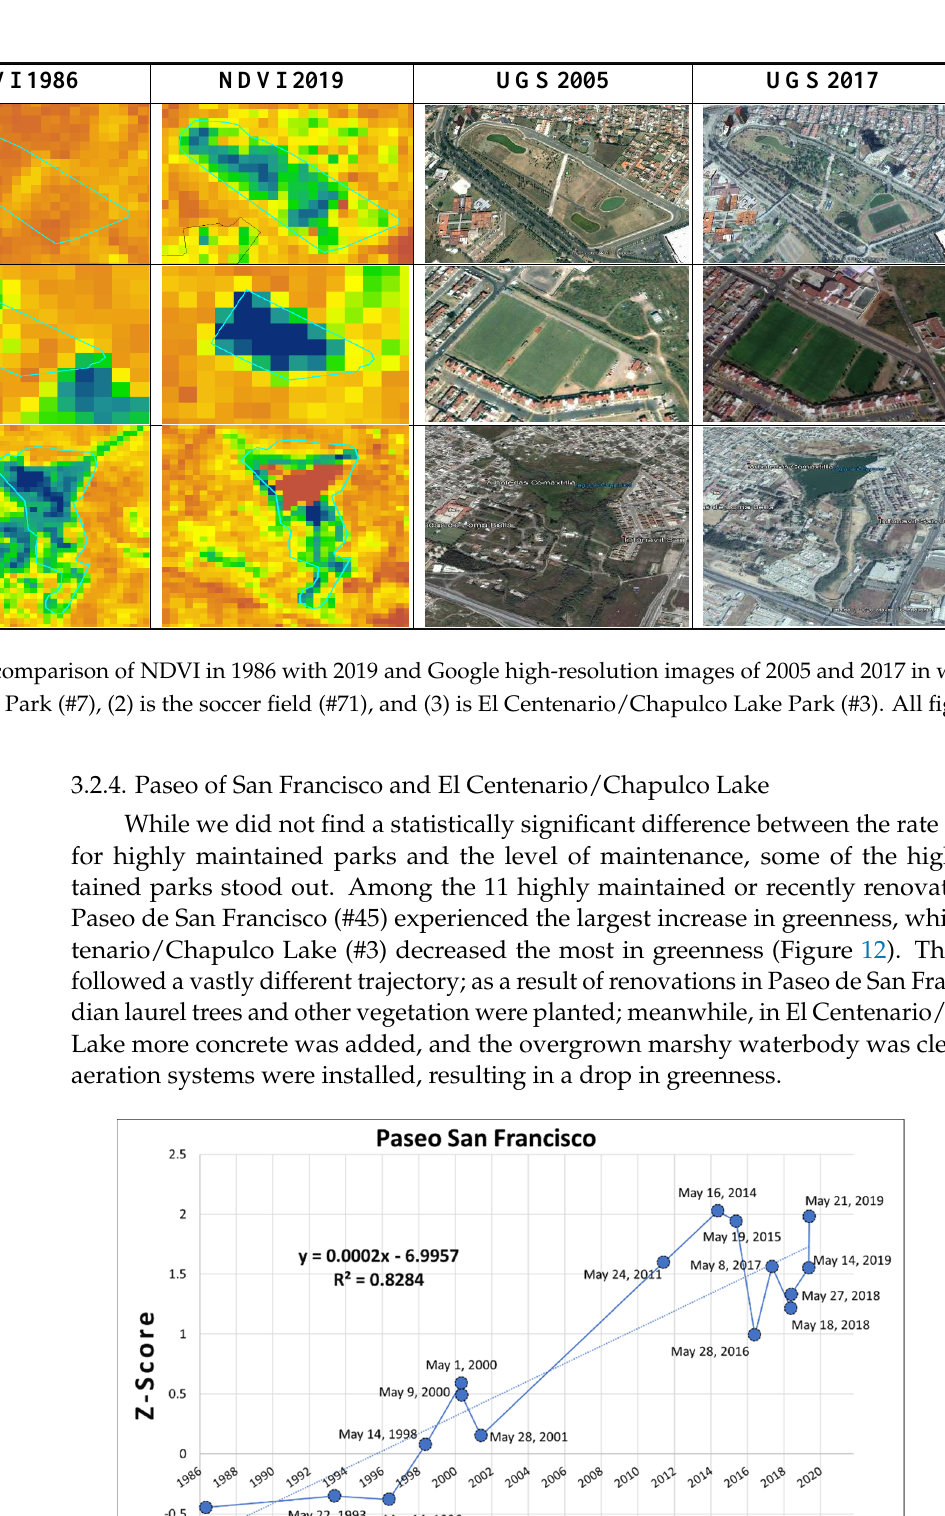
15 of 27 Figure 10. Log-linear regression of UGS size and change in greenness over the 34-year period. 3.2.3. Hypothesis-3 Hypothesis-3: UGS Maintenance Effect. We also tested whether highly maintained and recently renovated UGSs showed a